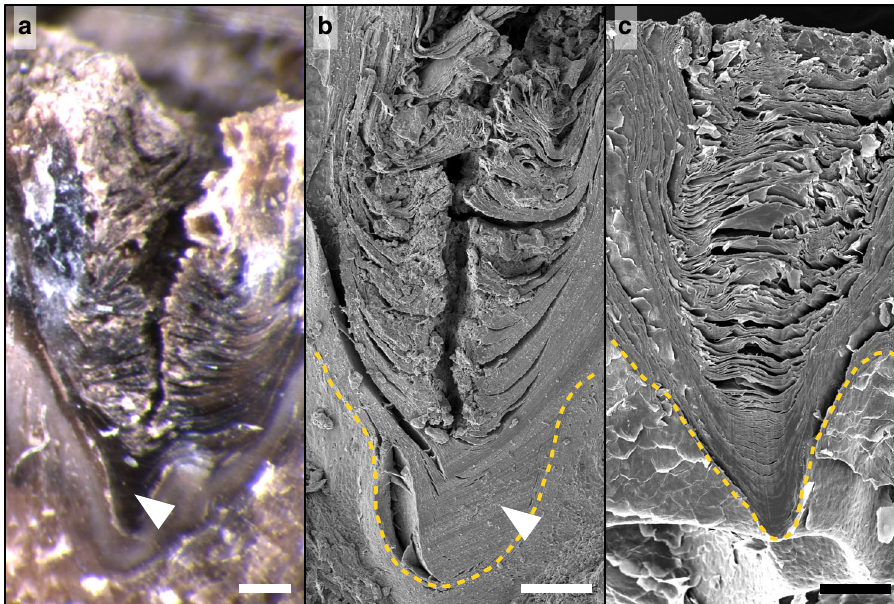
Fig. 2 Stratum corneum morphology of cracked and uncracked samples. a , b Light ( a ) and electron ( b ) microscopy of sections cut perpendicular to a crack reveal a fracture that is characterised by an alignment of the stratum corneum keratin sheets on both sides of the fracture and a very small degree of recoil. Moreover, the innermost sheets of the stratum corneum remain intact (arrowheads), probably due to their higher hydration level. c Section cut through an uncracked sample of stratum corneum , showing a morphology identical to that of cracked samples apart from the lack of material discontinuities. Dashed lines in b , c : boundary between the stratum corneum and the viable epidermis. Scale bars: a 250 μ m; b 150 μ m; c 100 μ